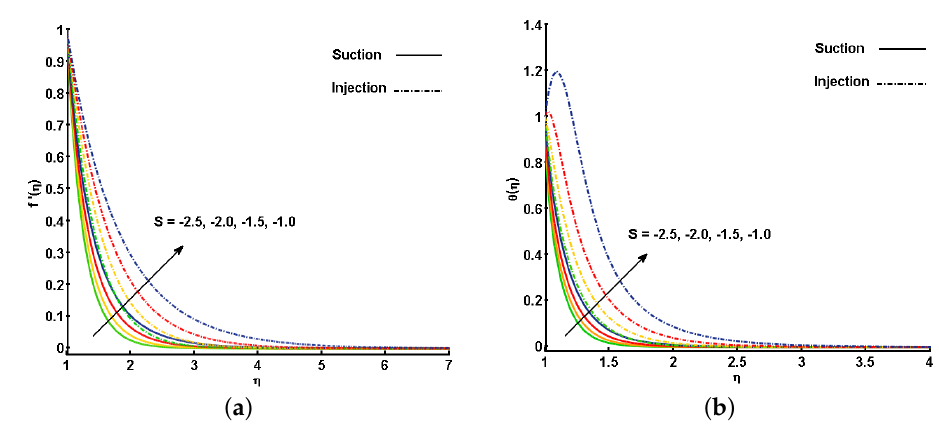
Figure 3. Effect of unsteadiness parameter ( S ) on ( a ) velocity profile ( f (cid:48) ( η )) and ( b ) temperature profile ( θ ( η ) ).